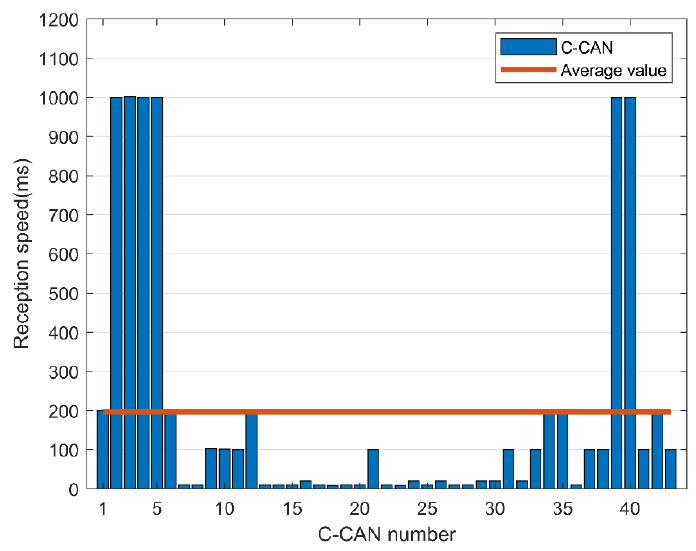
Figure 14. Message reception speed in C-controller area network